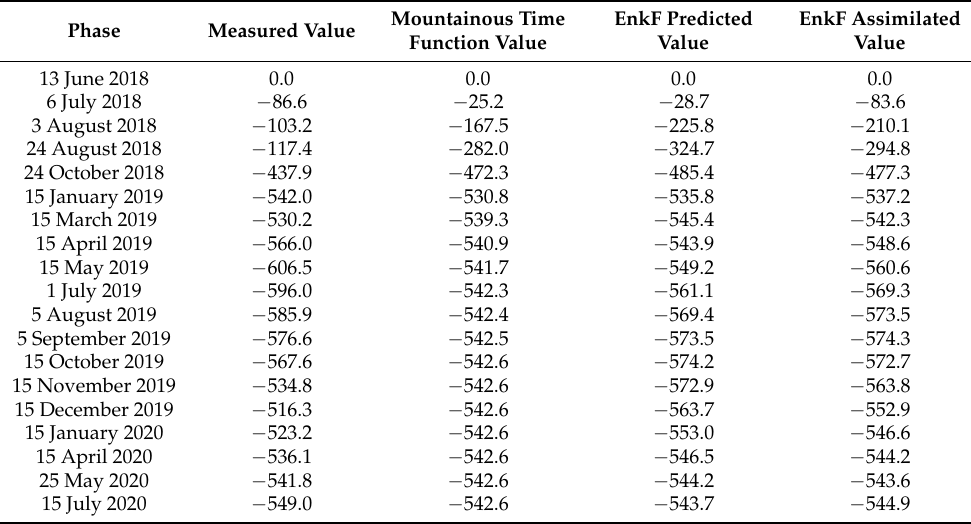
Table A1. The subsidence values of the observation point A21 acquired by different methods